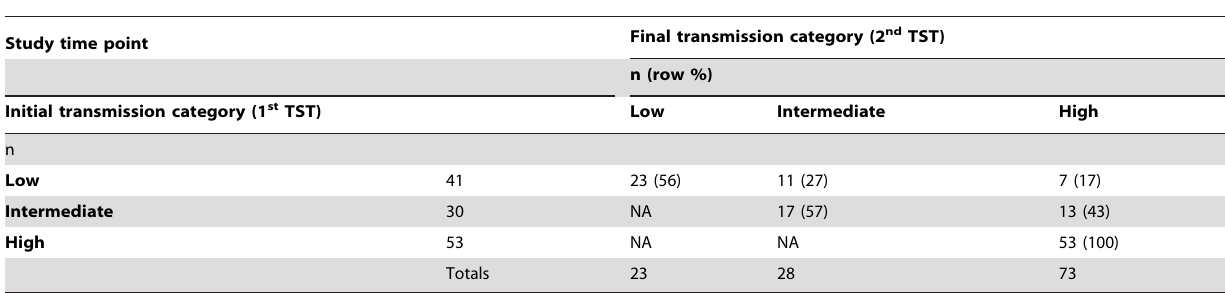
Table 2. Distribution of households according to study M. tuberculosis transmission categories by study time point.